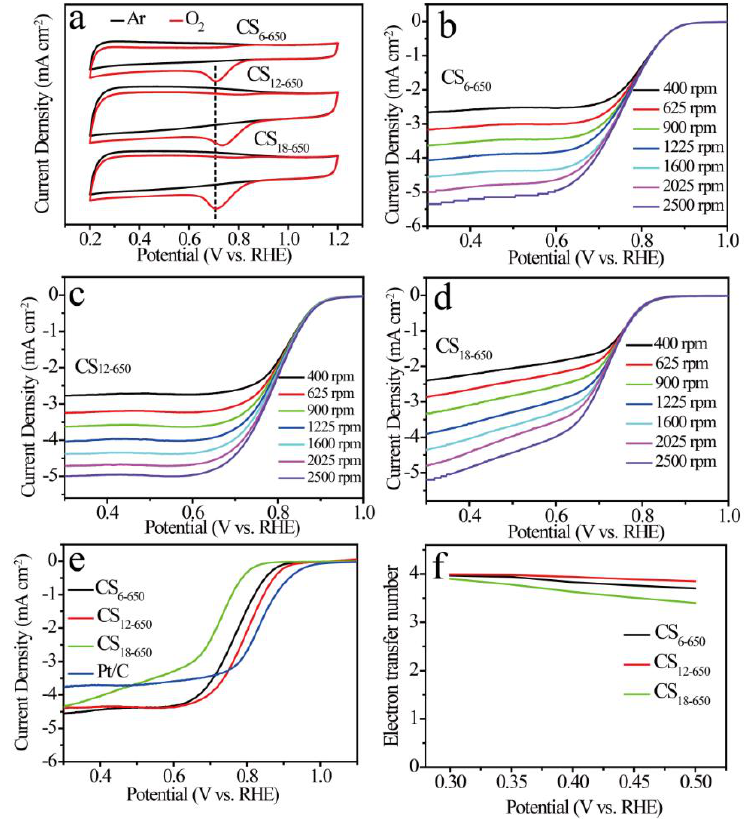
Figure 5. CV curves of CS 6-650 , CS 12-650 and CS 18-650 in Ar- or O 2 -saturated 0.1 M KOH aqueous solution at a scan rate of 50 mV/s ( a ). Linear sweep voltammetry (LSV) curves of CS 6-650 ( b ), CS 12-650 ( c ) and CS 18-650 ( d ) in O 2 -saturated 0.1 M KOH aqueous solution at different rotation speeds. LSV curves of CS 6-650 , CS 12-650 and CS 18-650 and the commercial 20 wt% Pt/C in O 2 -saturated 0.1 M KOH aqueous solution at a rotation rate of 1600 rpm and a scan rate of 10 mV/s ( e ). Electron transfer numbers obtained from The Kouteckye–Levich (K–L) plots of CS 6-650 , CS 12-650 and CS 18-650 ( f ).